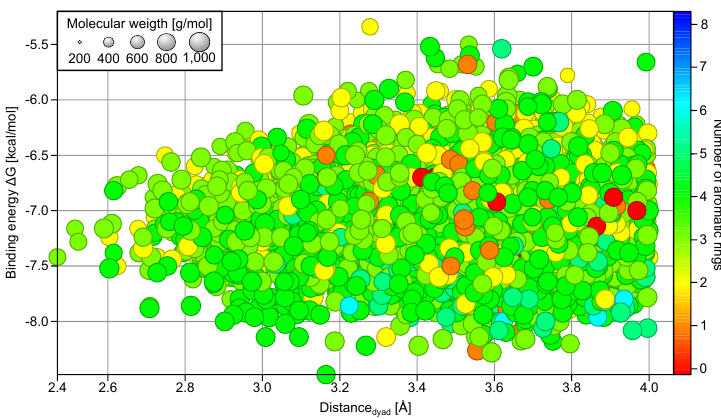
Figure 2. Distribution of the best binding synthetic compounds in terms of d dyad ( x -axis), ∆ G ( y -axis), number of aromatic rings (color), and molecular weight (circle size). The ∆ G and d dyad values are averages obtained from ensemble docking. Only compounds with ∆ G < − 5.0 kcal/mol and d dyad ≤ 4 Å are